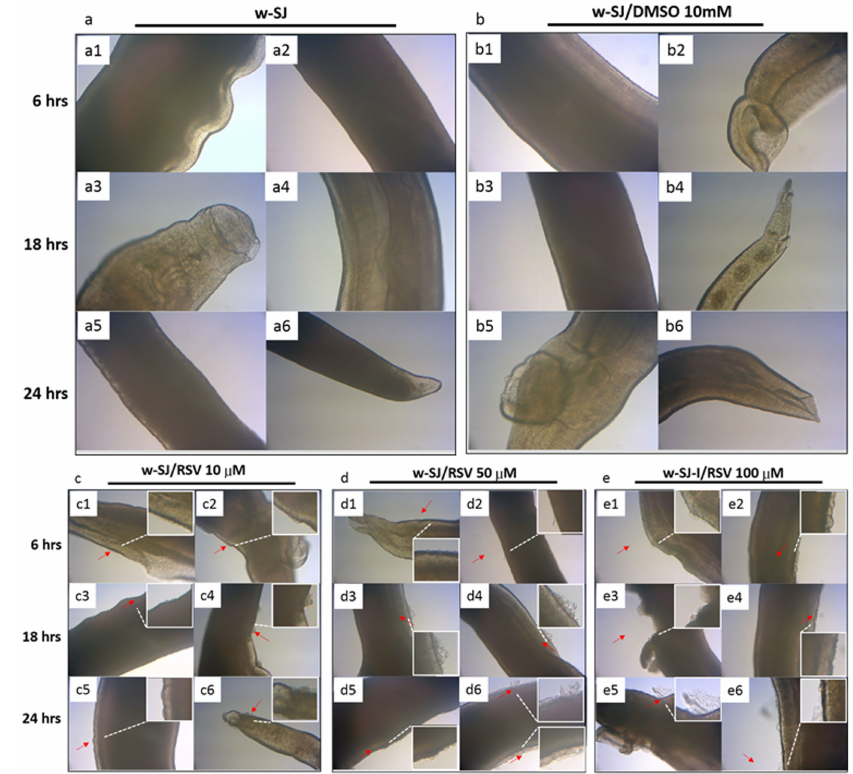
Figure 7. RSV causes damage to adult S. japonicum worms. Representative optical microscopy images show the external epidermal morphology of adult S. japonicum worms treated with RSV at a concentration of 10, 50 and 100 µ M for 6, 18 and 24 h. The severity of body surface damage increased with increase in RSV concentration and treatment time ( c – e , red arrows) compared with the positive controls ( a ) and negative controls ( b ). Drastic swelling and epidermal shedding were observed after treatment with RSV at 50 and 100 µ M for 18 and 24 h (d3–d6 and e3–e6, red arrows). Uninfected worms were used as the positive controls, and worms treated with 10 mM DMSO were used as the negative controls (n = 5 for each